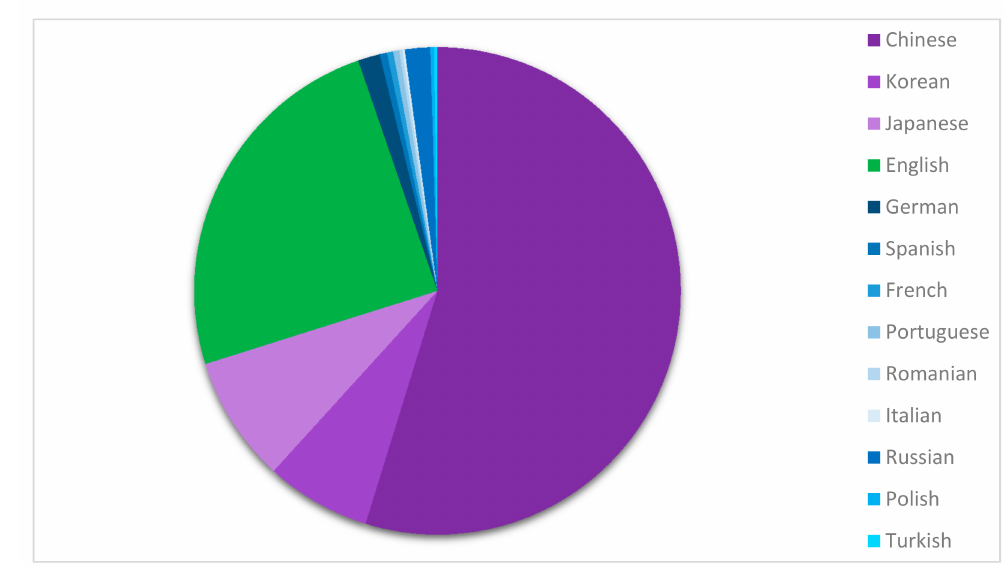
Figure 5. Analysis of language of patent registrations involving antimicrobial silver over the past decade with major contribution of Chinese (55%), English (25%), Korean (7%), Japanese (8%), and others